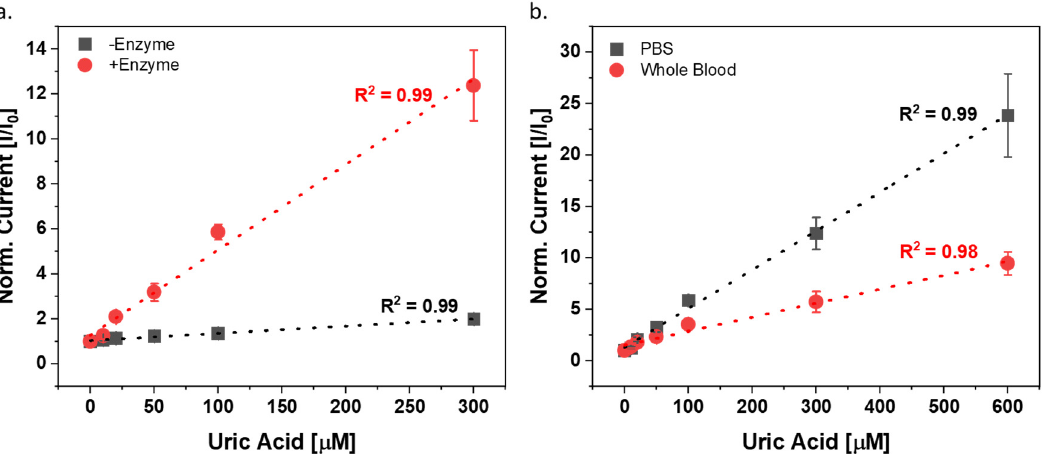
Figure 6. Enzymatic O3ES response via amperometry: ( a ) in the presence and absence of uricase enzyme in PBS; and ( b ) in the presence of uricase enzyme in PBS and whole blood.